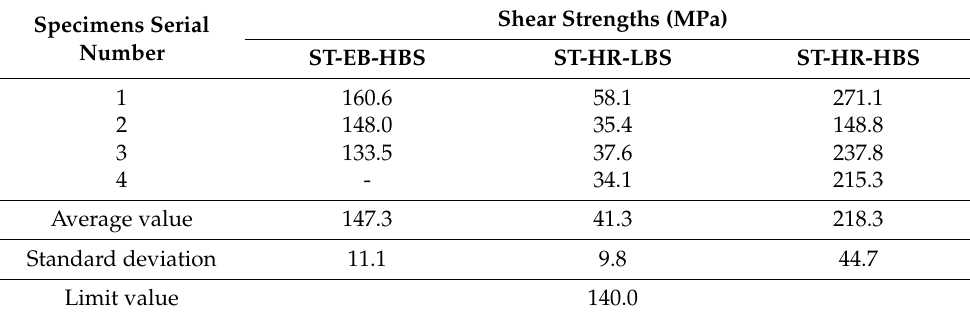
Table 1. Shear strengths at the bonding interface.